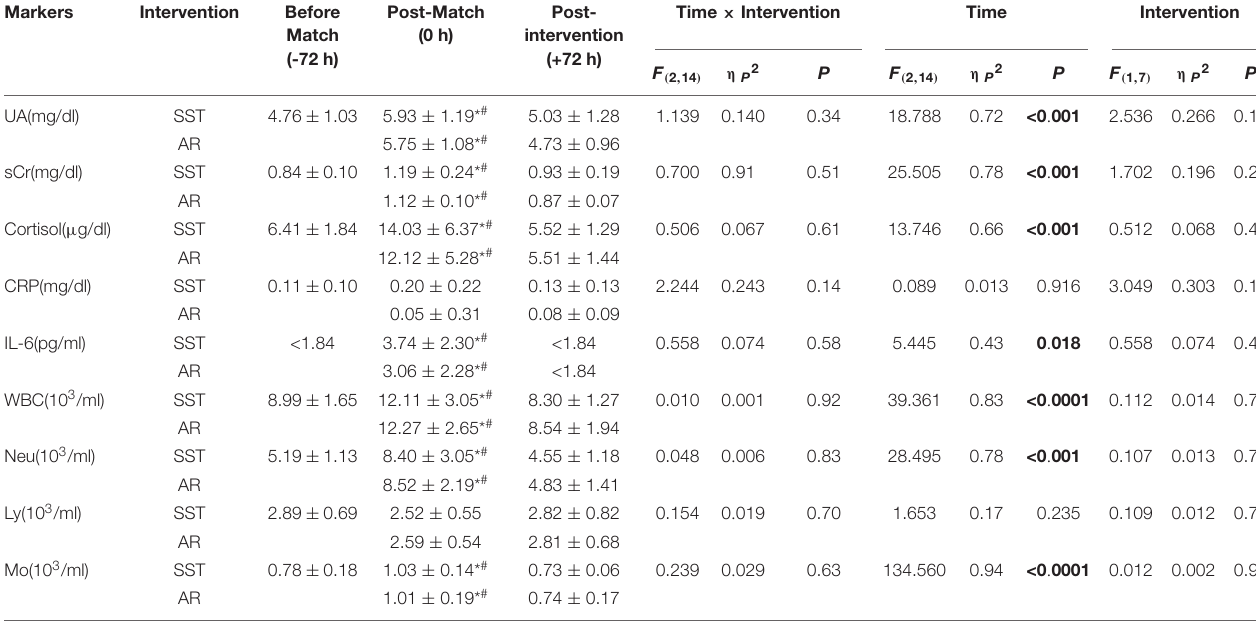
TABLE 2 | Descriptive statistics (mean ± SD) for all blood markers obtained in the two treatments (SSG and AR) with F -values, partial eta squared ( η p 2 ), and P -values derived from the two-way ANOVA repeated measures for interaction (time × intervention) and main effects of time and intervention. Markers Intervention Before